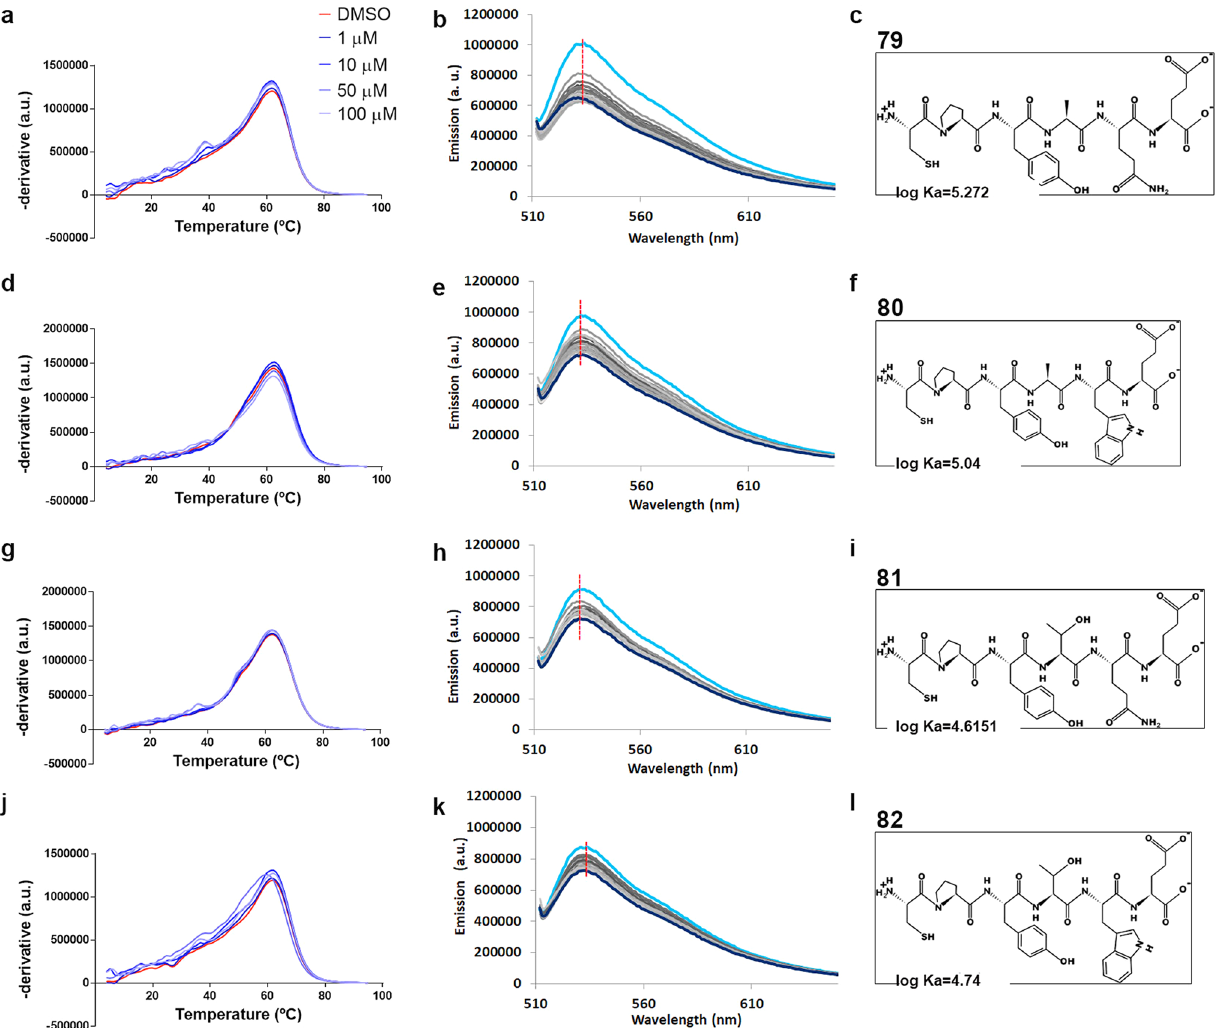
Figure 6. Candidate peptides interact with CUG RNA without affecting thermodynamic stability. The graphs show the first derivatives of RiboGreen fluorescence (DSF assay) versus temperature ( a , d , g , j ; 4 technical replicates per condition). and Thiazole orange fluorescence titration experiments ( b , e , h , k ; FID assay) for peptides 79 ( a – c ), 80 ( d – f ), 81 ( g – i ) and 82 ( j – l ). Experiment was performed per duplicate. DMSO 0.1% was used as a negative control. In Thiazole orange titrations, the intensity of the fluorescence progressively decreased with increasingly higher peptide concentrations (concentrations ranged from 0.03 up to 4 µM). The association constants (Ka) were calculated from FID assay data, which indicate that peptide 79 interacts with the (CUG) 23 RNA probe with the highest affinity, although differences in binding affinity were low among all four peptides. DSF data also supports the binding of peptides to the RNA probe but did not detect significant changes in its secondary Candidate peptides interact with CUG RNA with similar affinities. A fluorescent indicator dis- placement (FID) assay was used to investigate the nature of the interaction between the candidate peptides and the toxic RNA. Thiazole orange (TO) is an asymmetric cyanine intercalator with little fluorescence when free in an aqueous solution but strong emission when forming complexes of different nature with nucleic acids. These characteristics can be exploited to study changes in the interaction between the dye and the nucleic acid of interest in response to external factors 39,40 . Specifically, the fluorescent reporter interacted with the (CUG) 23 RNA probe resulting in fluorescent emission. By adding the peptide, it was possible to displace the TO, caus- ing its fluorescence to decrease. In this way, by analyzing the fluorescence emission at different RNA-peptide ratios, the value of the peptide’s association constant for the CUG sequence could be indirectly calculated. For all peptides, a progressive reduction in fluorescence was observed in response to increasing concentrations of each peptide (Fig. 6b, e, h, k); in the case of peptide 79 (k log = 5.273 ± 0.007), the greatest decrease in fluorescence was observed, followed by peptide 80 (k log = 5.04 ± 0.01) and the smallest change was observed with peptides 82 and 81 (respectively k log = 4.74 ± 0.02 and k log = 4.65 ± 0.02) (Fig. 6c, f, i, l). However, it should be noted that in none of the cases did the level of fluorescence observed reach the characteristic values of a single-stranded RNA. This indicates that, although there was a clear interaction between the peptides and the RNA molecule, peptides